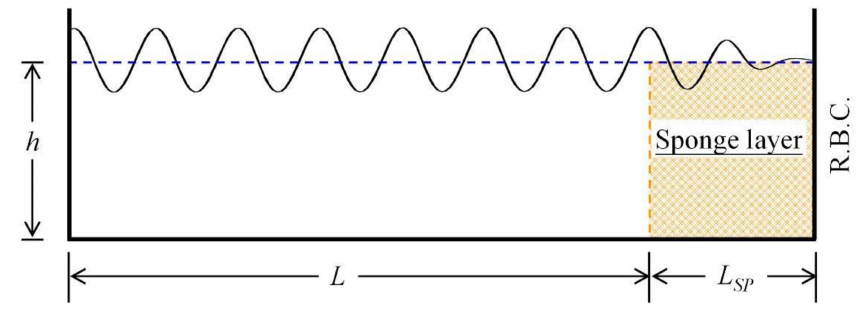
Figure 2. Sketch of a vertical 2D numerical wave tank.